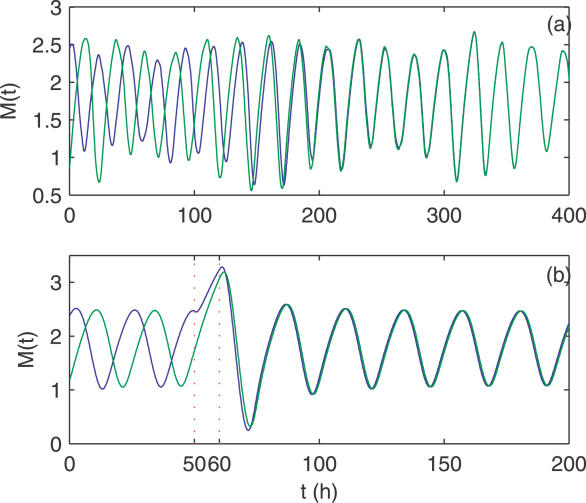
Synchronization of Two Goldbeter Circadian Oscillators(A) Induced by common light noise; and (B) induced by a short duration of bright light.